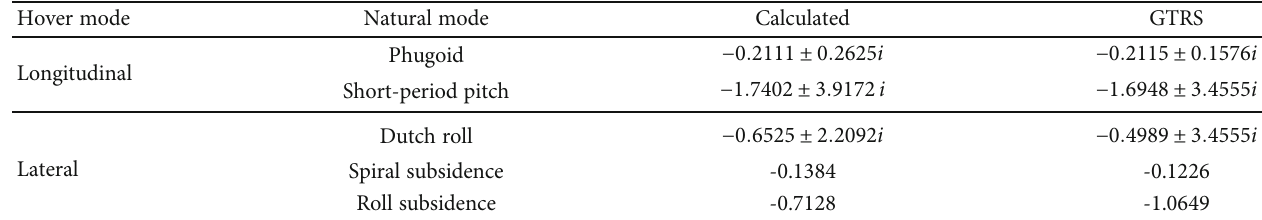
Table 3: Airplane mode ( V = 200kt ) eigenvalues validation.